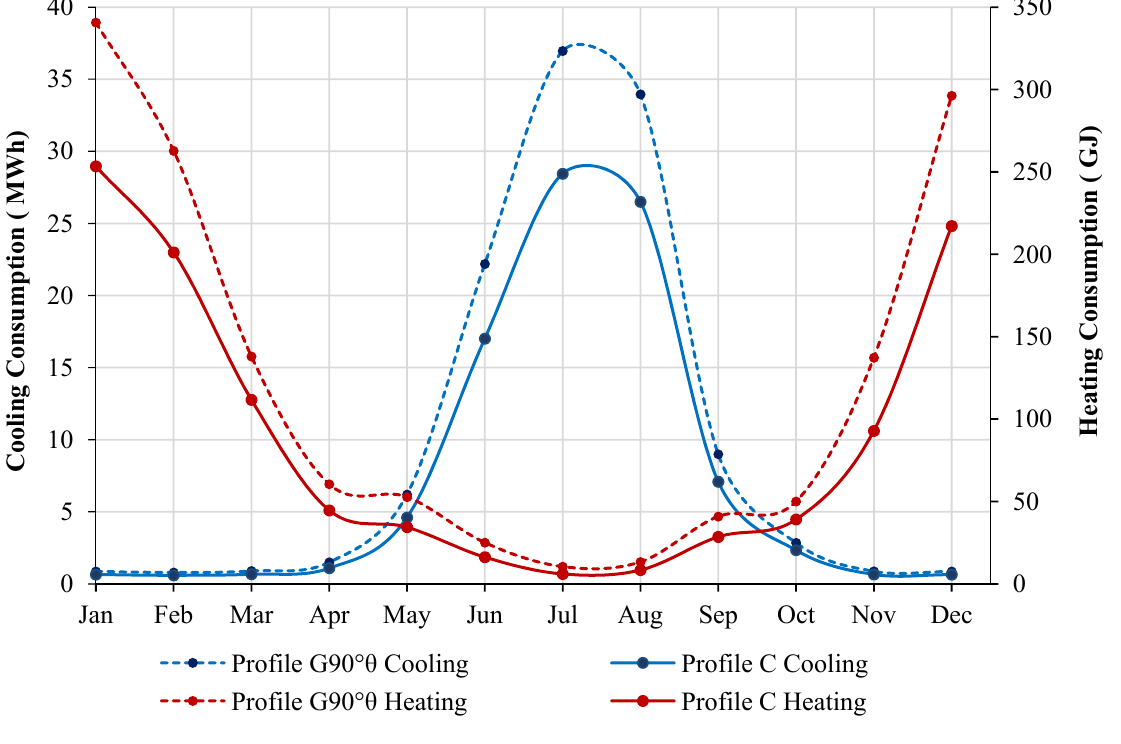
Figure 11. Comparison of energy consumption between Profile B and Profile D90° θ for Toronto